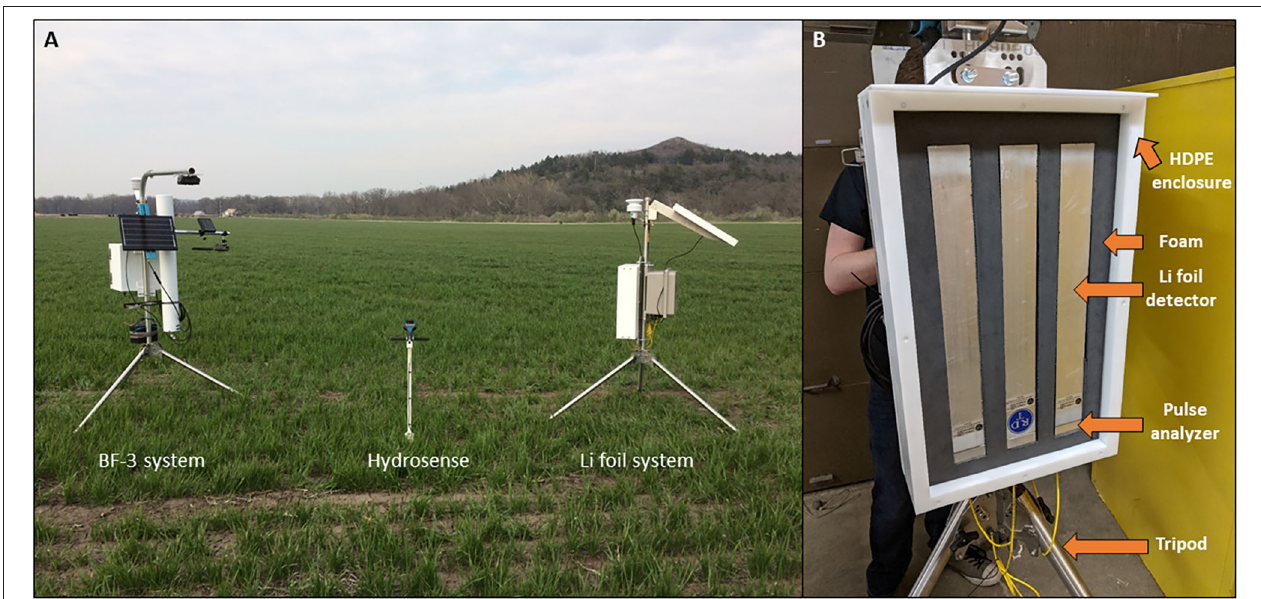
FIGURE 1 | (A) Boron trifluoride system (left), Hydrosense hand-held soil moisture sensor (center), and Li foil system (right) in a field planted with winter wheat at the Konza Biological Research Station near Manhattan, Kansas, USA. The two systems were located about 3.5m apart near the center of the field. (B) Front view of the Li foil system mounted on a tripod without the front panel of the moderating high density polyethylene (HDPE) enclosure. The image shows the three Li foil modules embedded in vibration dampening foam and the 2.5cm thick, weatherproof HDPE enclosure. The enclosure is 60cm in height, 30cm wide, and 15cm